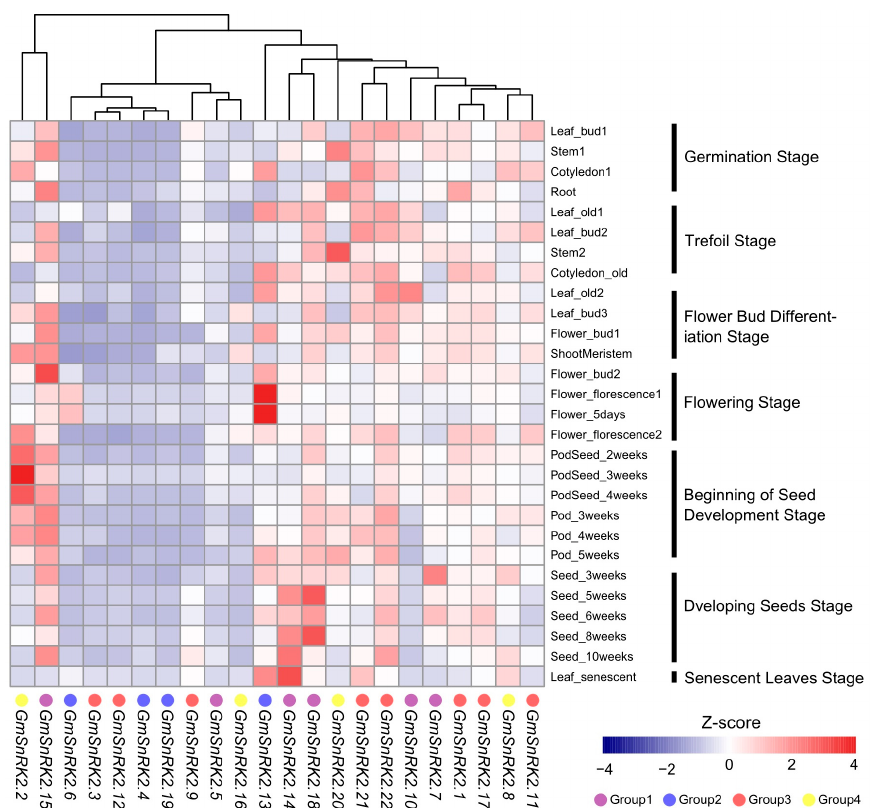
Figure 3. Expression analysis of GmSnRK2s during growth and development of different tissues of soybean. The RNA sequencing (RNA-Seq) dataset of 28 tissues of soybean collected from different development stages were obtained from the National Center for Biotechnology Information (accession number: SRP038111) to generate heatmap. The color scale indicating Z-score value is given below. Group 1, Group 2, Group 3 and Group 4 are marked as purple, blue, red and yellow circles, respectively. The different stages are marked by vertical black lines.